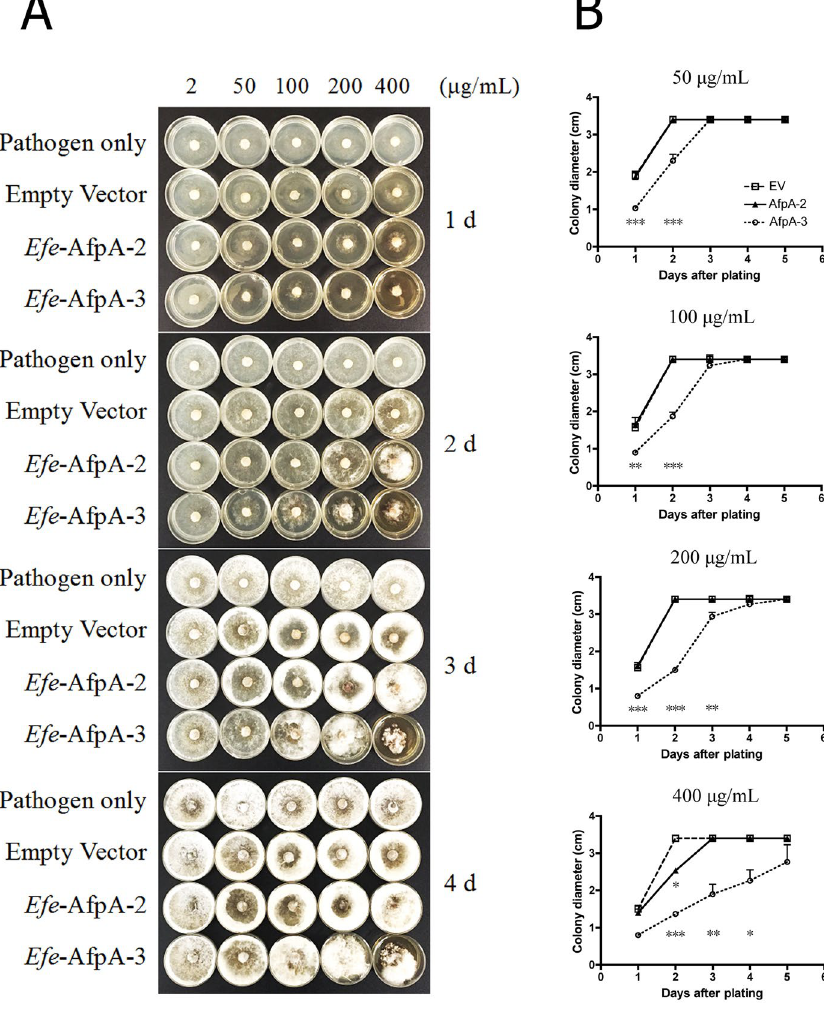
genomes of E . baconii and E . aotearoae . To illustrate the evolutionary relationships among the Epichloë spp. that possess an antifungal protein gene, a maximum parsimony phylogenetic analysis was conducted of the con- served MCM7 gene, including introns, of the 17 Epichloë isolates for which whole genome sequences are available (Fig. 8). The MCM7 gene encodes a subunit of the minichromosome maintenance complex 38 and is frequently used in fungal phylogenies 39, 40 . The E . inebrians and E . gansuensis sequences were designated as outgroups for rooting the tree since they are considered the basal Epichloë spp. 41, 42 . The presence or absence of an antifungal protein gene in each species is indicated on the MCM7 phylogenetic tree. The patchy distribution of the presence of an antifungal protein gene throughout the Epichloë spp. suggests there have been numerous instances of gene loss. A phylogenetic analysis of the antifungal protein gene DNA sequences, including introns, of the Epichloë spp. is shown in Fig. 9. A previous phylogenetic analysis of antifungal protein DNA coding sequences from Eurotiomycete and Sordariomycete fungi showed that the antifungal protein PAF from Pe . chrysogenum (Trichocomaceae) was more closely related to similar proteins from Sordariomycetes than those from other Eurotiomycetes 17 and so is included in the phylogeny in Fig. 9. The coding sequence of the other similar antifungal protein from Pe . chrysogenum , PgAFP, is phylogenetically close to similar sequences from other Eurotiomycetes, as would be expected 17 , and is not included in Fig. 9. Also included is the sequence from Pochonia chlamydosporia (Clavicipitaceae), a parasite of nematode eggs 43 . The sequences from the insect pathogens Beauveria bassiana and